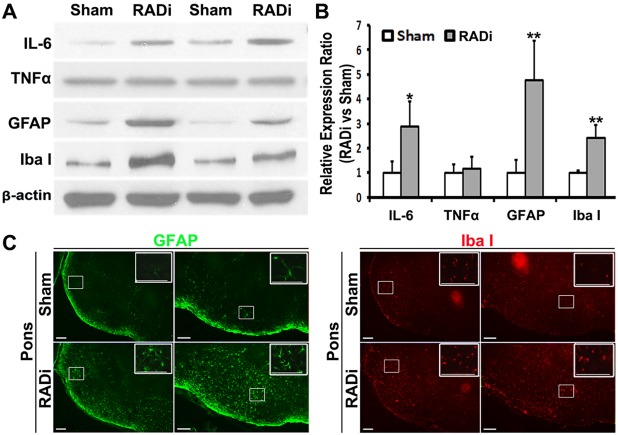
Proinflammatory and glial activation following RADi in the brain. (A) Western blots of proinflammatory cytokines IL-6 and TNFα, the glial-specific intermediate filament protein GFAP, and macrophage/microglia-specific protein Iba1 in two sham and RADi mouse brains at 3 dpi following 60 psi×60 RADi. (B) Statistical analysis of western blots. Data are presented as mean±s.d. and were analyzed by unpaired two-tailed Student's t-test. *P<0.05, **P<0.01; n=4 per group. (C) Photomicrographs of immunostaining showing increased GFAP- and Iba1-positive glia in the pons of sham and RADi brains at 3 dpi. Insets show higher magnifications of the boxed areas. Scale bars: 100 µm.